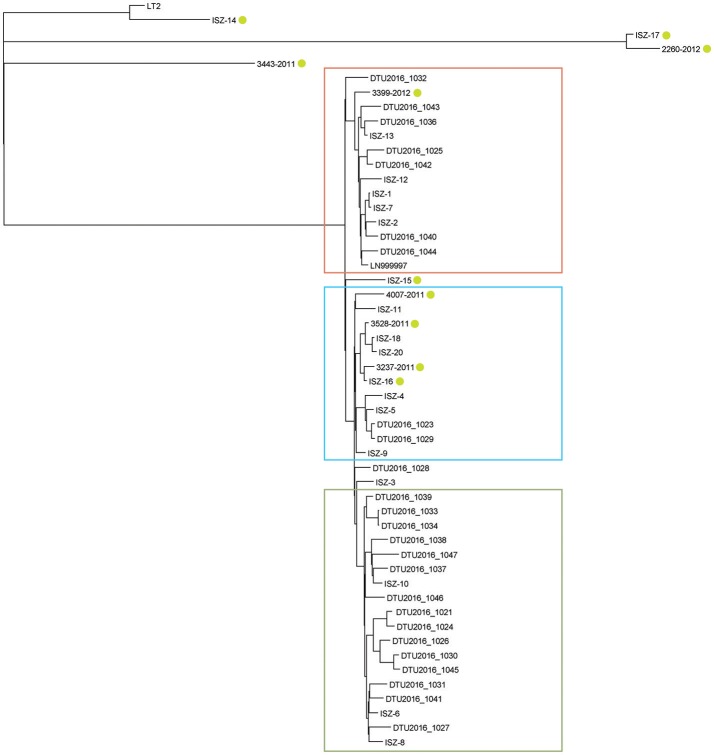
Hierarchical clustering with Manhattan distance and UPGMA over accessory genome presence/absence gene profile. All 50 the analyzed strains and the two reference genomes (LN999997 and LT2) are included.